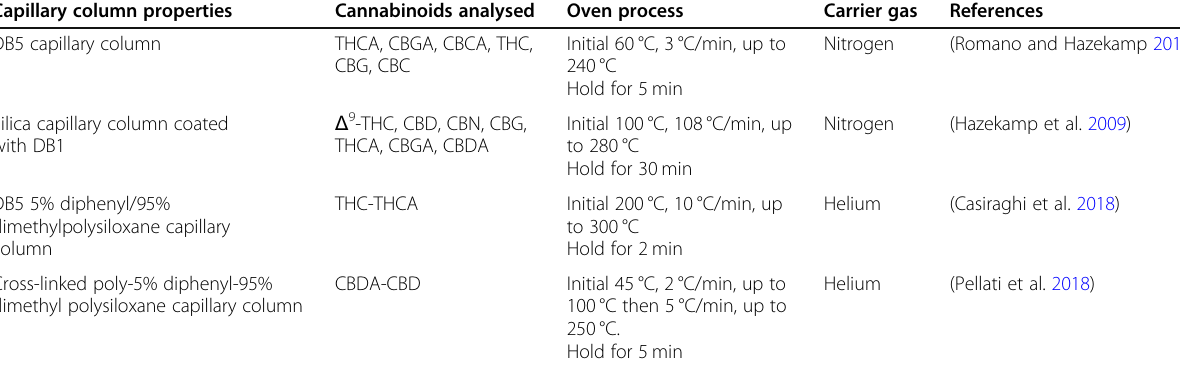
Table 2 Key properties of GC-FID method for analysing cannabinoids with a capillary column in four different